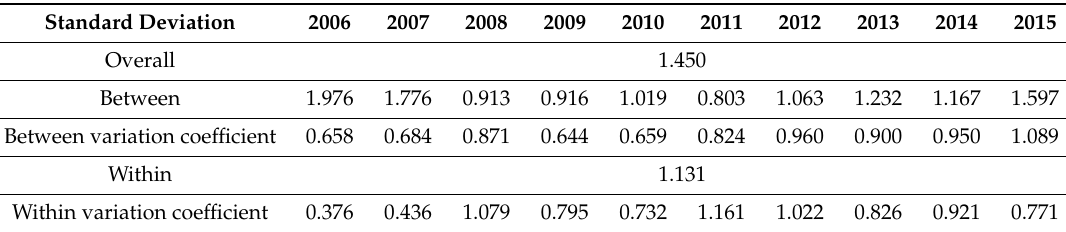
Table 5. Variability of Tobin’s Q, and untransformed variables.